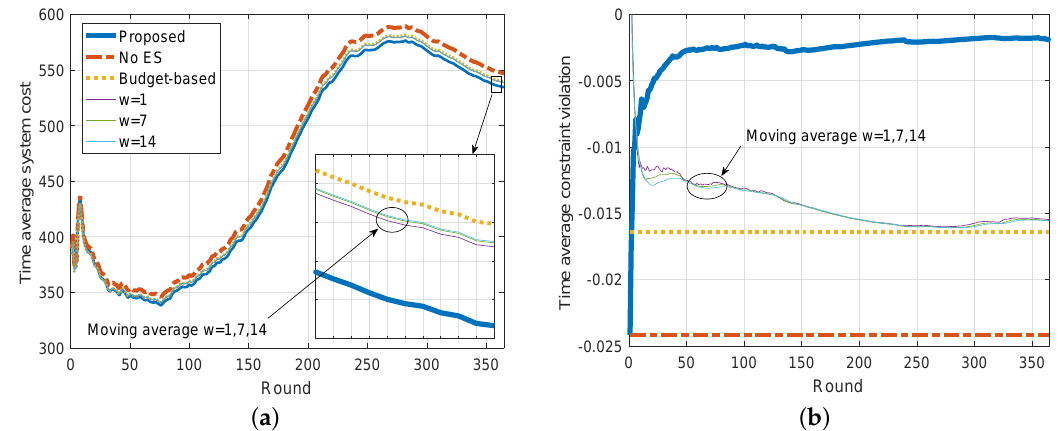
Figure 6. Energy storage capacity allocation performances in the 100-home system. ( a ) Time average system cost. ( b ) The highest time average constraint violation of budget balance.